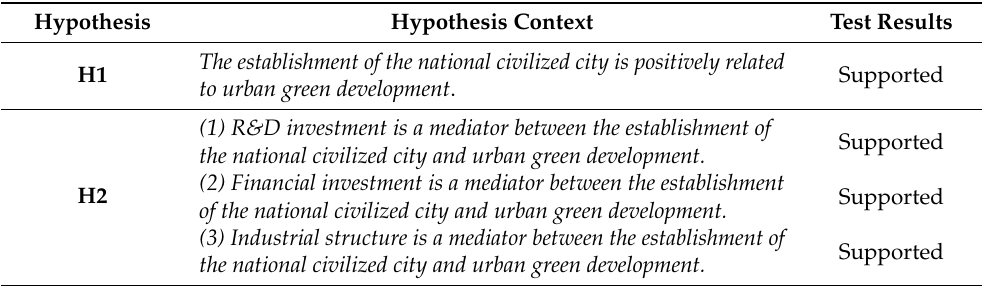
Table 8. Hypothesis test